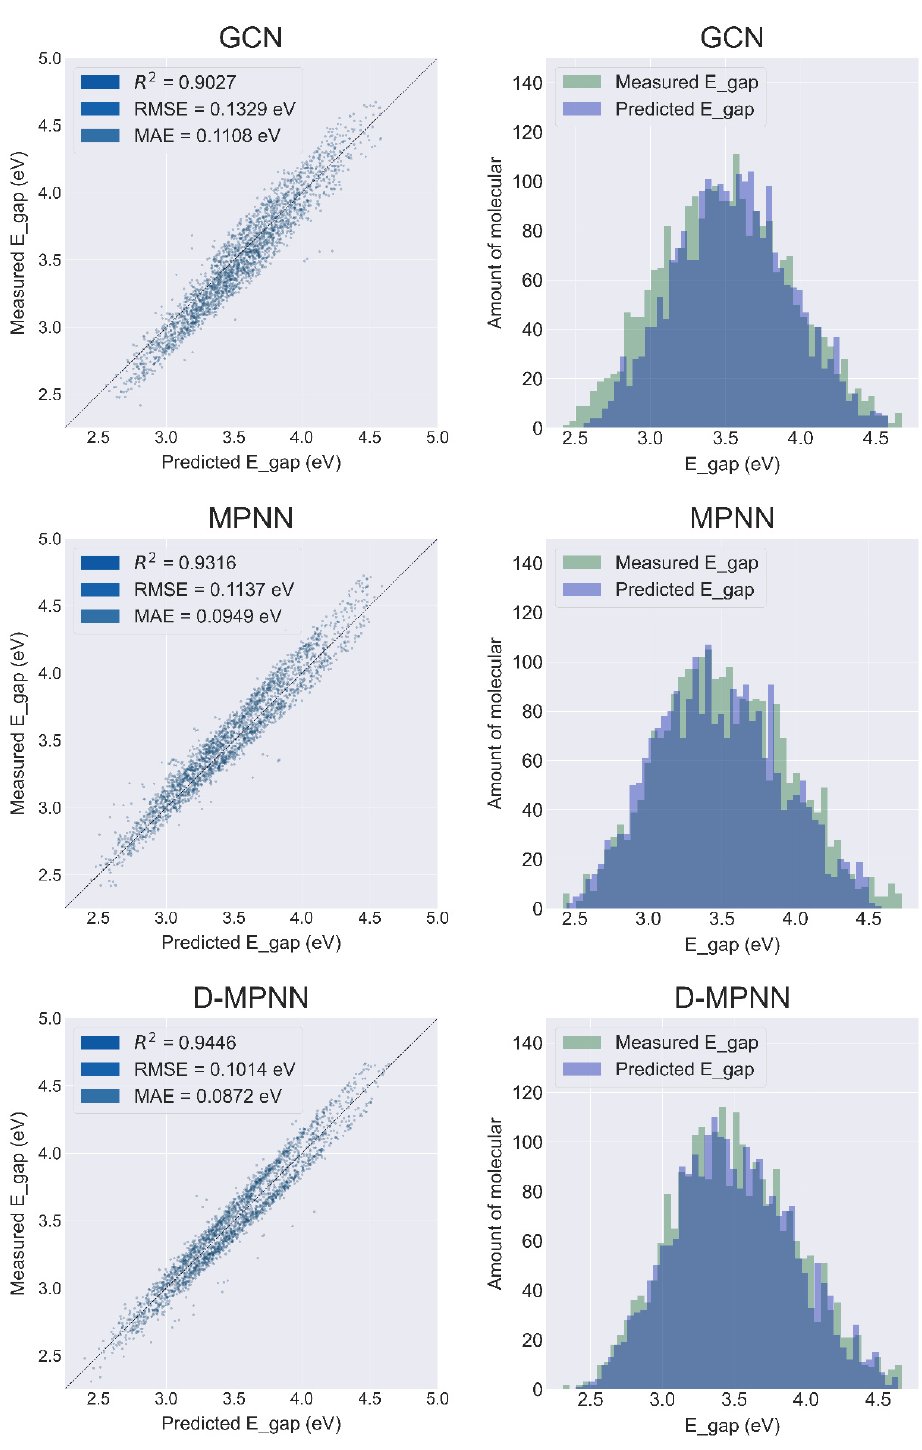
Figure 3. Results of the prediction sets for the models GCN, MPNN, and D-MPNN in the direction of the graph structure. The left column shows the regression plot of the model predictions, and the right column shows the distribution plot of the model prediction data and the data stored in the database. The larger area of the overlap in the data distribution plot on the right indicates better performance of the model prediction.